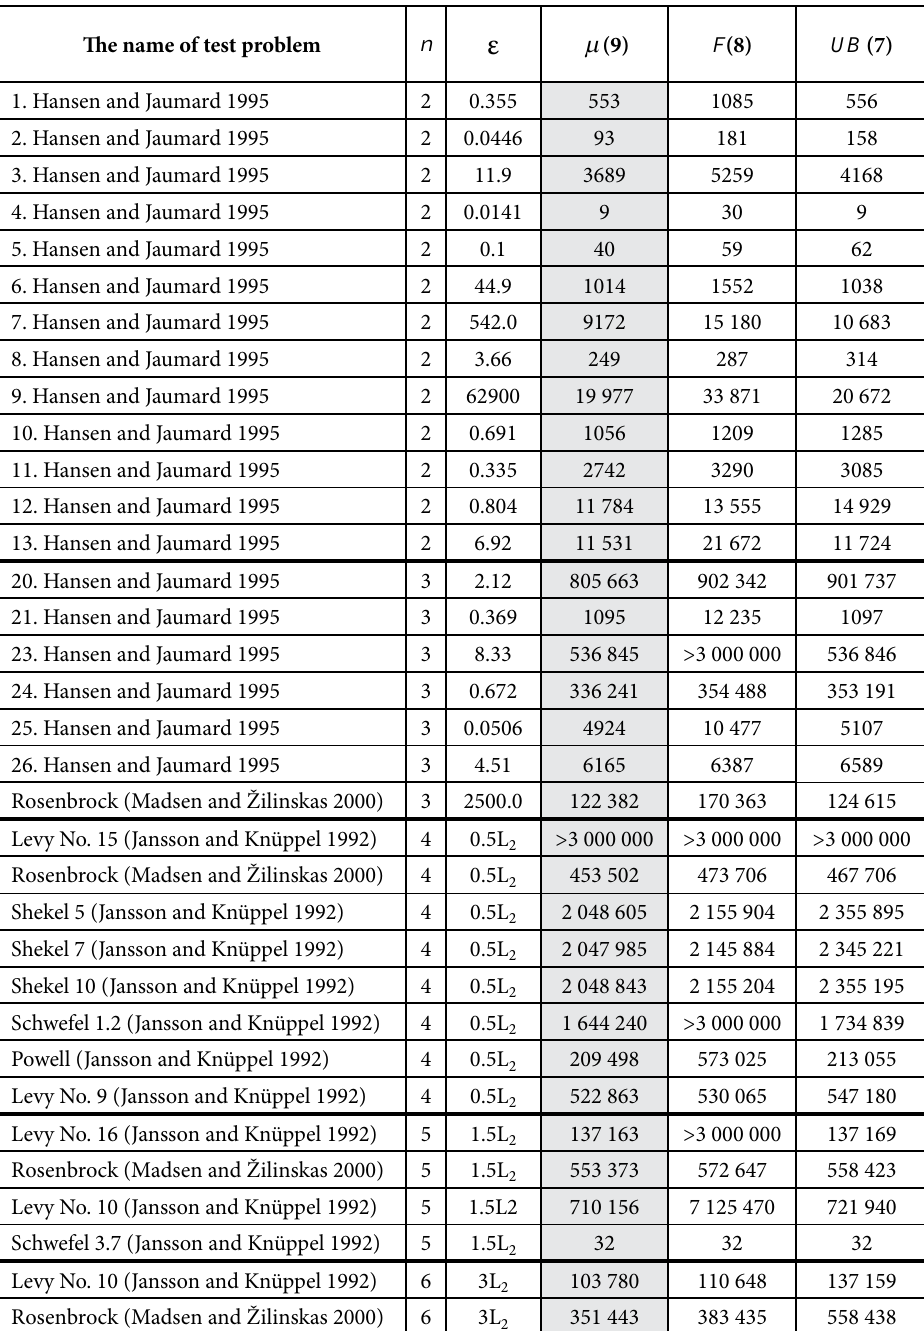
Table 1. The numbers of function evaluations for algorithm with various bounds The name of test